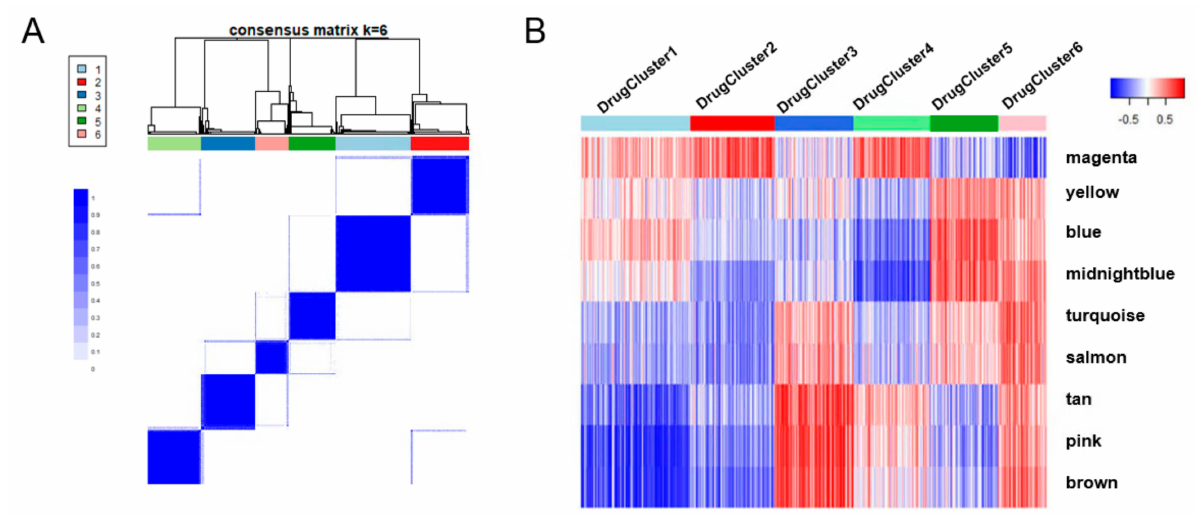
Figure 3. Consensus clustering analysis using the correlations between drug responses and eigengenes of preserved modules. ( A ) The consensus clustering plot revealed the 6 clusters. ( B ) The heatmap demonstrated unique patterns as drug fingerprints using correlations between the drug responses and preserved